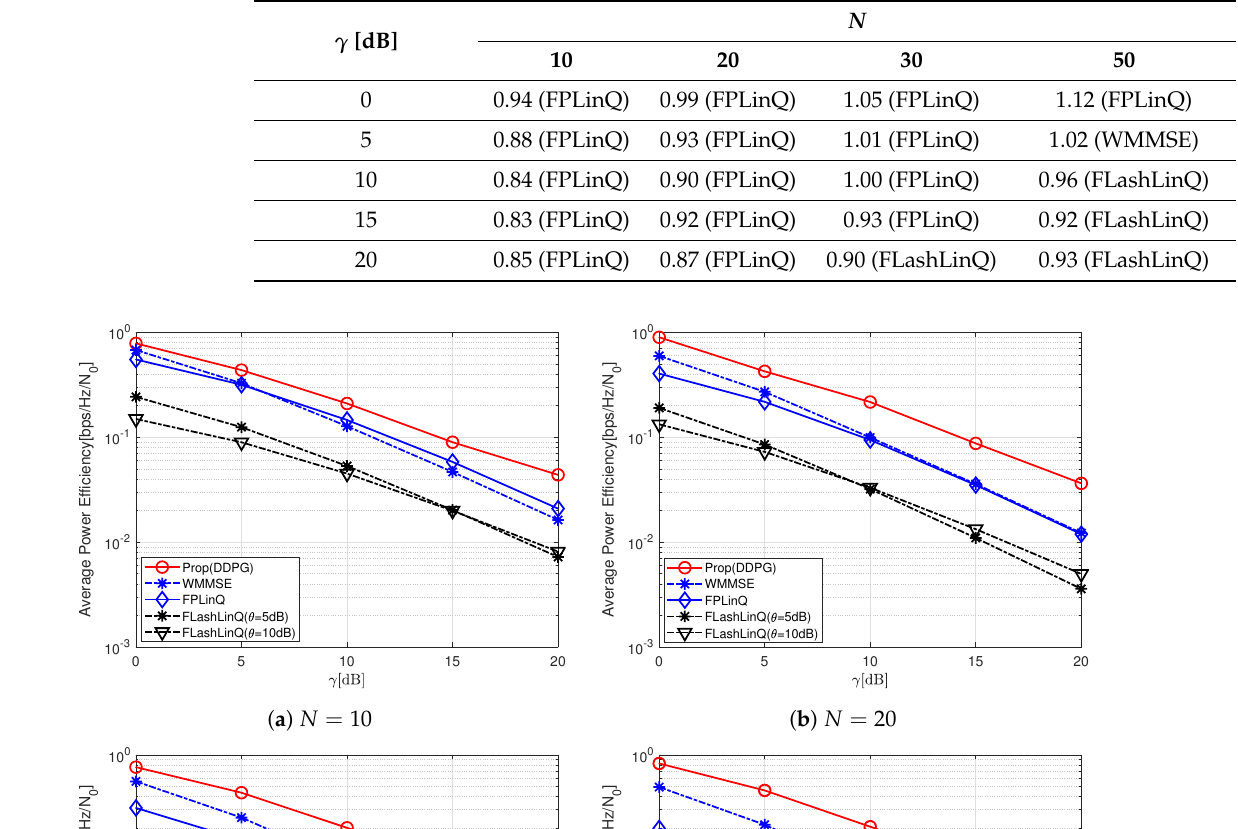
Table 1. The average sum-rate ratio of the proposed scheme to the best-performing reference scheme. The schemes in parentheses denote the reference scheme with the highest average sum-rate.